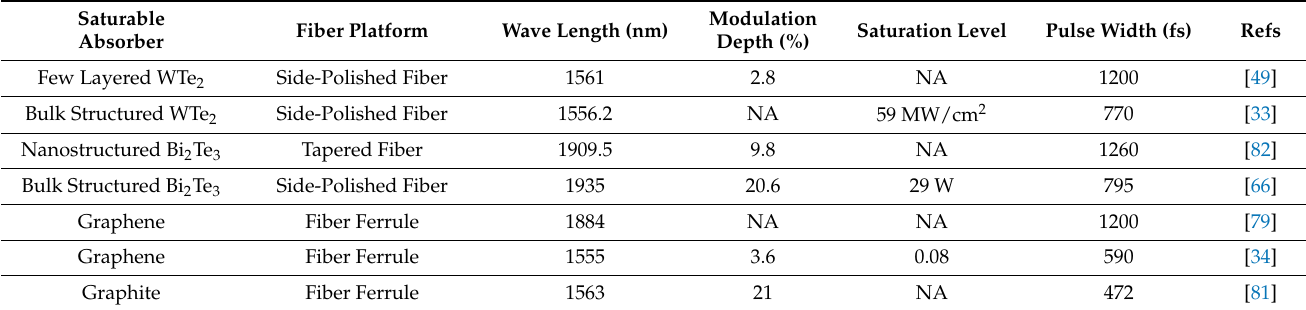
Table 1. Output performance comparison of mode-locked fiber lasers using highly stacked 2D material SAs and others.